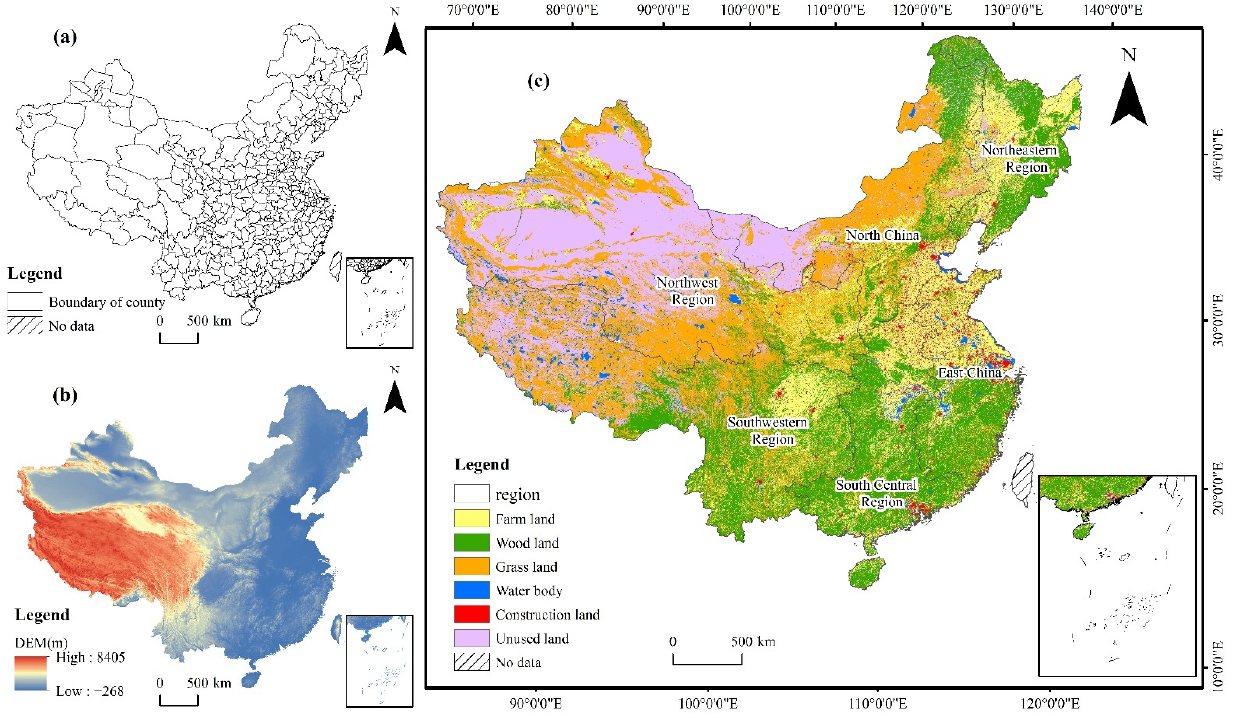
Figure 1. Map of the study area (( a ): prefecture-level and above cities of China, ( b ): DEM of China, ( c ): LUCC and six regions of China).